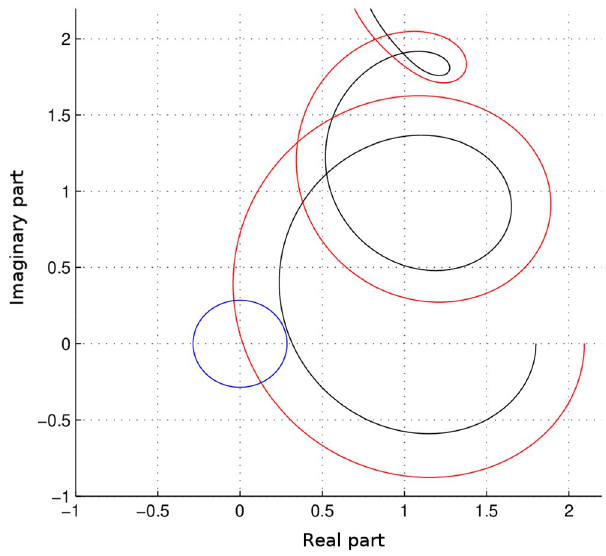
Fig 5. Function jω Θ VSM + 1 + pe jτ 1 ω + qe jτ 2 ω plotted in the complex plane: Case with higher oscillation propensity (red), case with lower oscillation propensity (black). The radius of the blue circle centered in the origin and tangent to the curve is inversely proportional to the oscillation